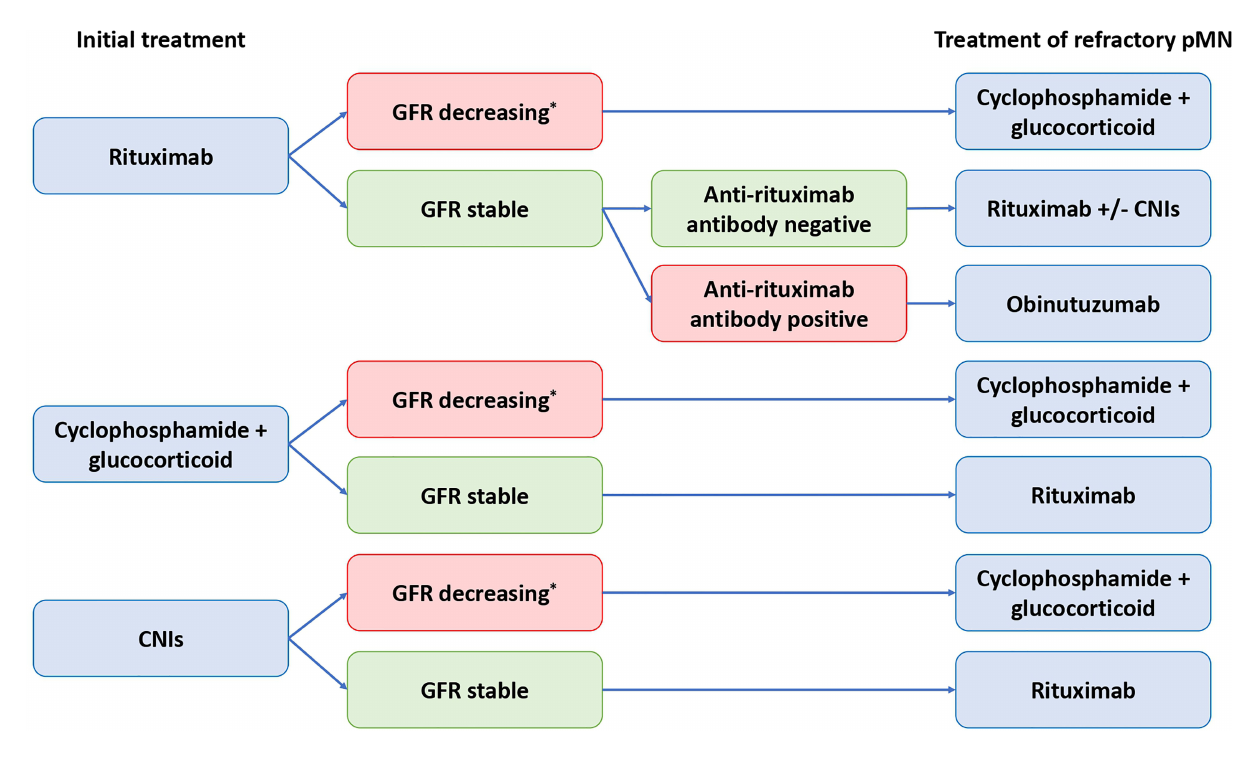
FIGURE 4 | Algorithm for management of patients with treatment-resistant primary membranous nephropathy. CNIs, calcineurin inhibitors; GFR, glomerular fi ltration rate; pMN, primary membranous nephropathy. *directly related to membranous nephropathy. To date, the alkylating agents (e.g. cyclophosphamide) are the only treatment with proven ef fi cacy to prevent end stage kidney disease (ESKD) and